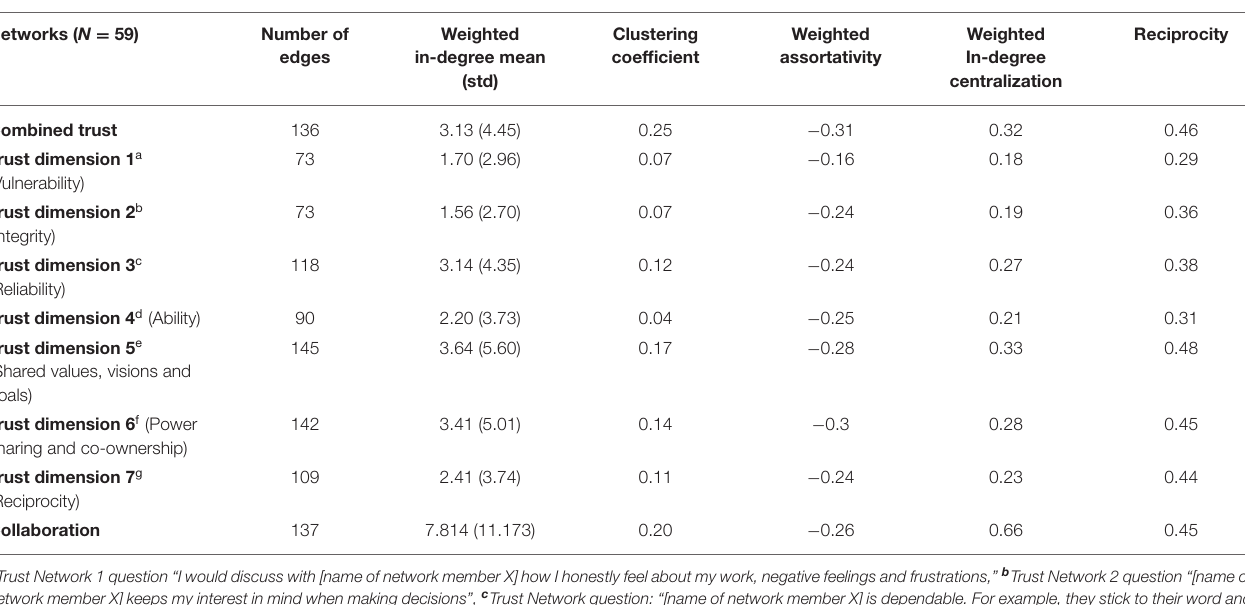
TABLE 3 | Social network analysis across trust networks. Networks ( N = 59) Number of